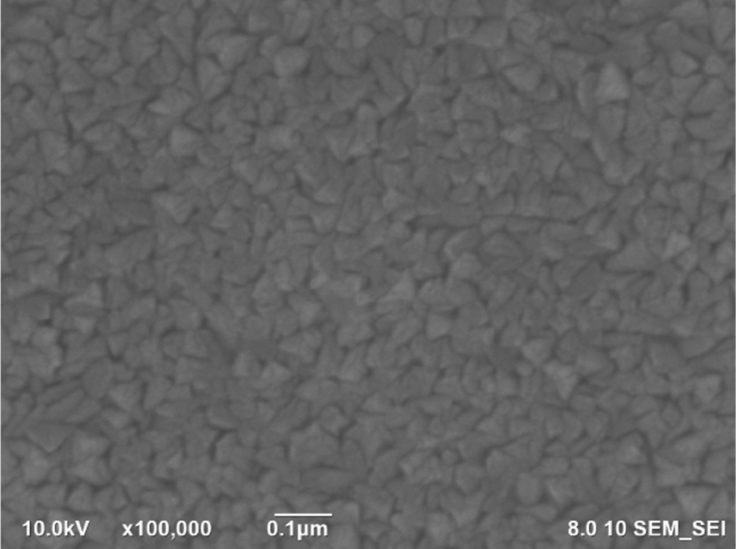
Figure 9. SEM images showing grain size and morphology of TiN/Ti 8p thin film.